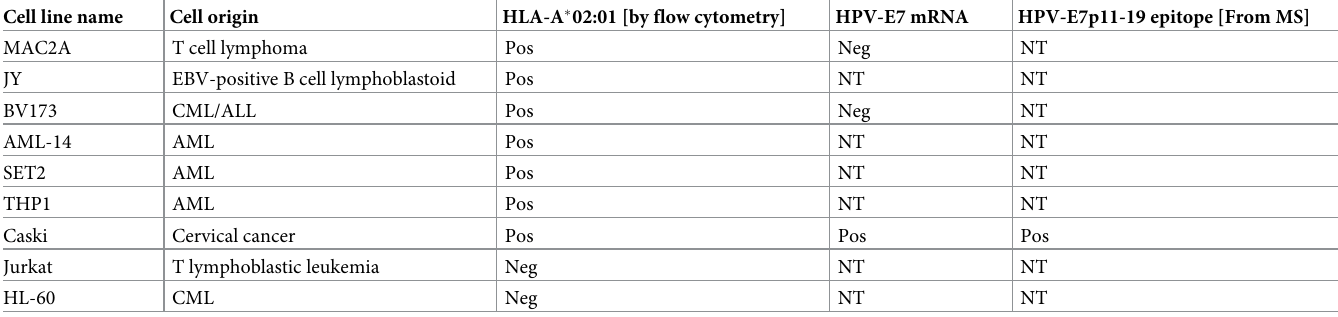
3, 4, 5, 6, and 7. Differential binding to HPV-9AAAA peptide among the three mAbs further demonstrated that only 3F8 binds to the middle amino acids of the HPV-E7p11 peptide. In T2 stabilization assays, HLA-A2 expression was partially reduced with alanine substitution at position 4 and 7, [Fig 2B] that might have contributed to the reduced binding of the mAbs 1B1 and 2A5 [Fig 2C and 2D]. These data suggested that the mAb 3F8 recognition required most of the amino acids in the middle of the peptide and was thus more specific for the HPV-E7p11/HLA-A2 complex. To further assess the specificity of the mAbs, a panel of HLA-A2-positive or negative cell lines [Table 3] that are either HPV positive or negative, were tested for the binding by the three mAbs. The presentation of the targeted HLA ligand YMLDLQPET on the cell surface of the cervical cancer cell line Caski, which had previously been reported to present the epitope Table 3. Cell lines used for mAb